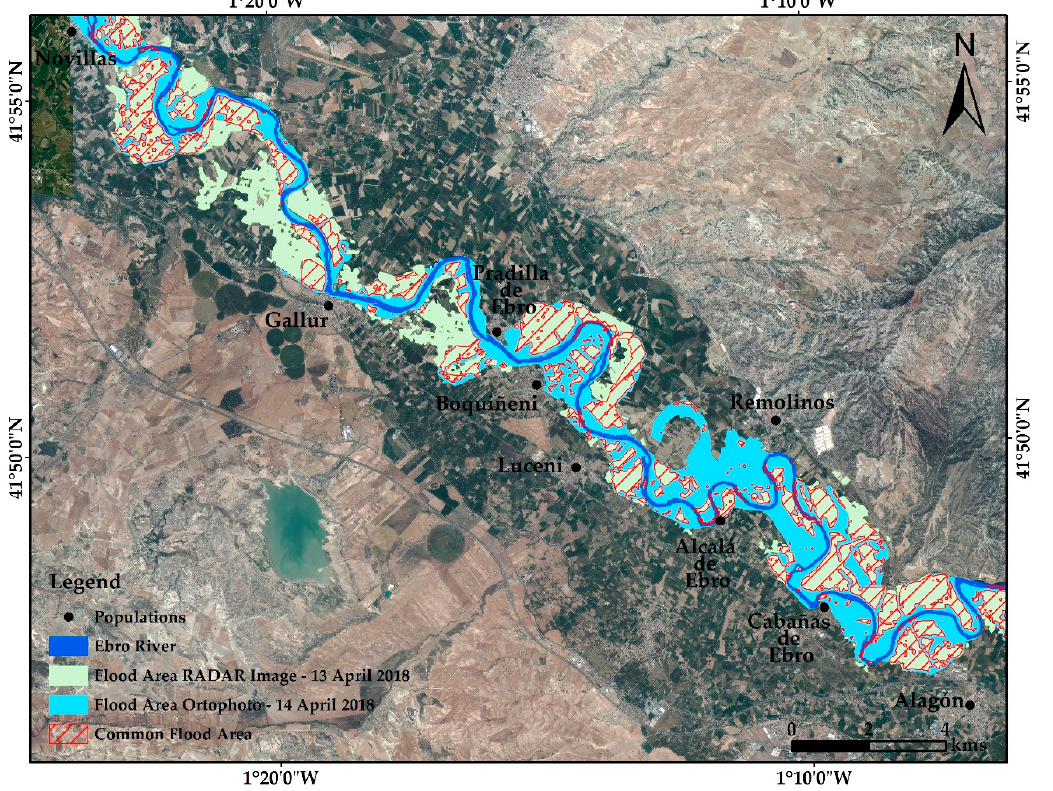
Figure 15. General map of comparative flooding between the RADAR image of 13 April 2018 and the orthophotography provided by the CHE on 14 April 2018 in Ribera